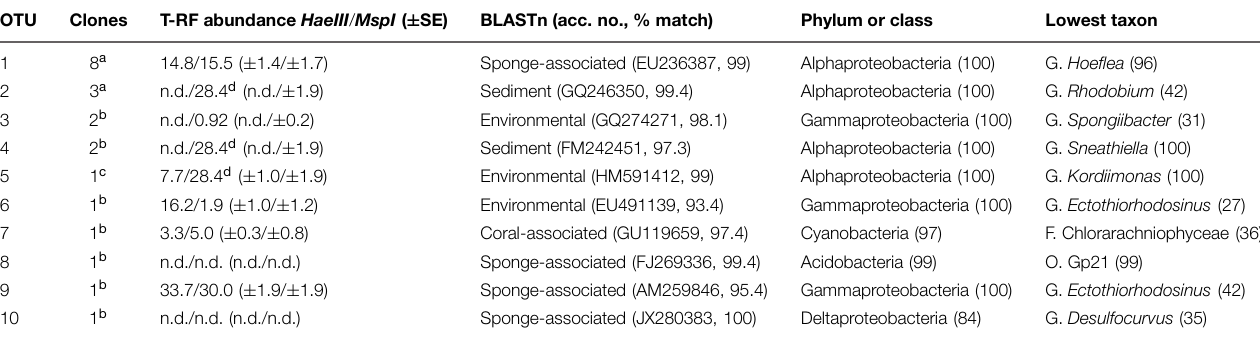
TABLE 2 | Bacterial OTUs obtained from clone library analyses, number of clones in each OTU, closest BLASTn match (identity percentage in parenthesis) and source, class and lowest taxonomic classification (confidence percentages in